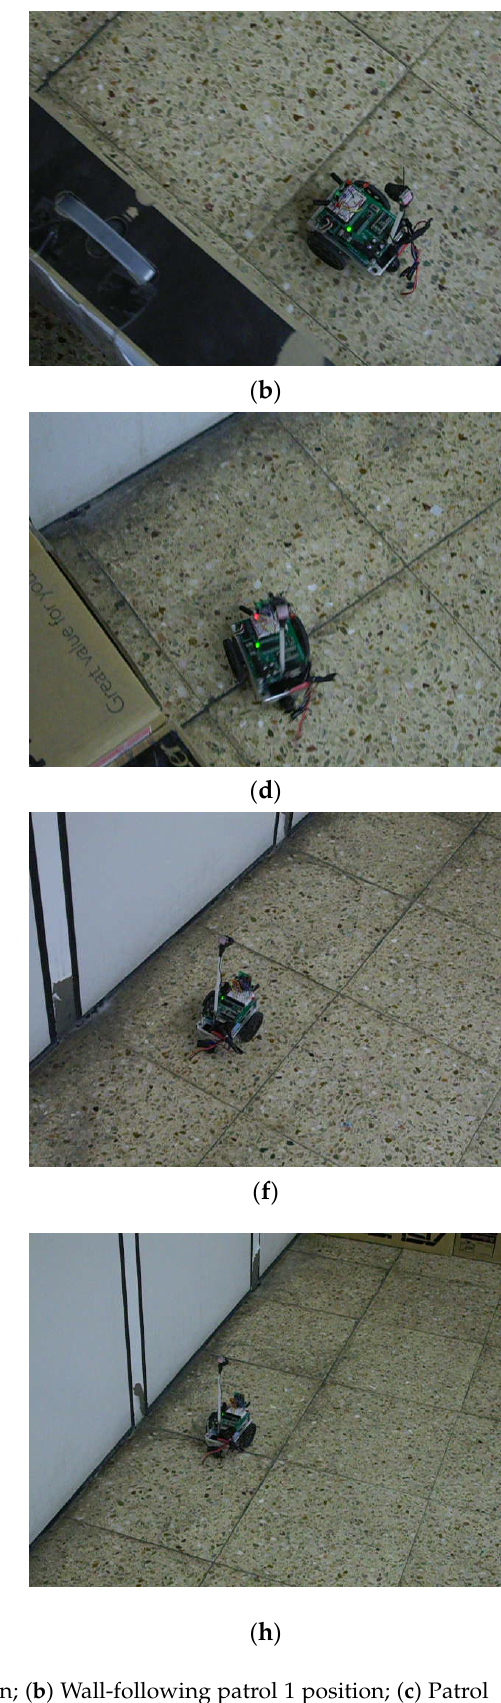
Figure 25. Testing field of indoor patrol.